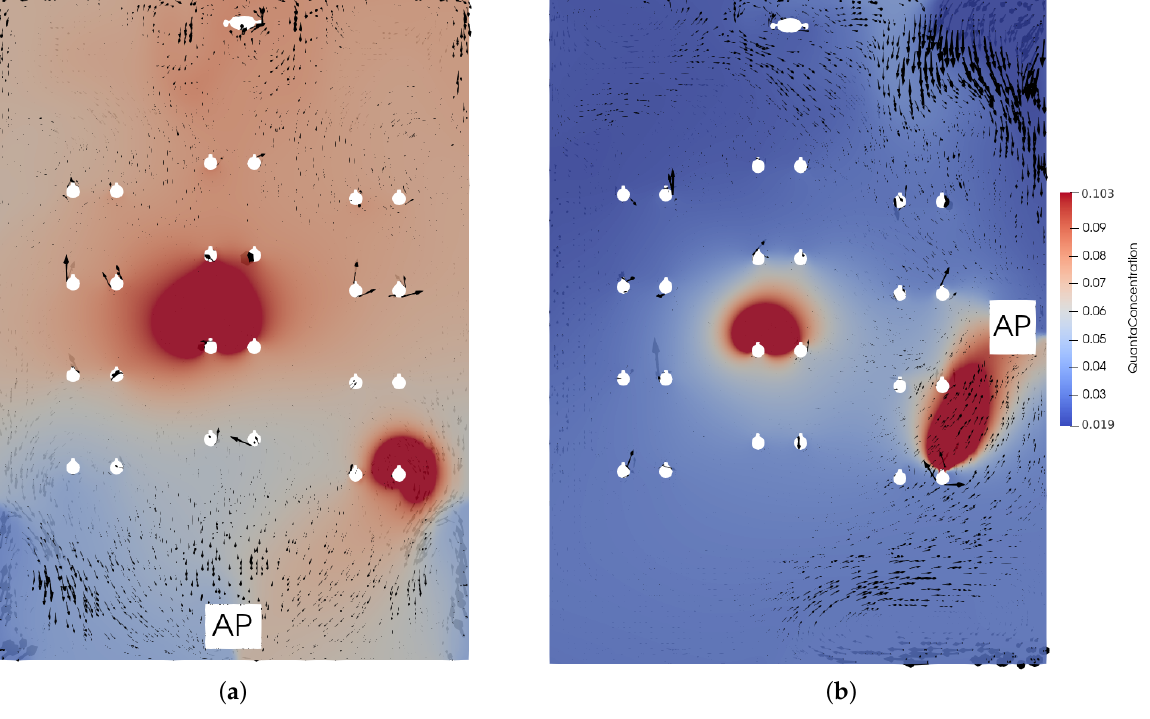
Figure 7. Quanta concentration and velocity vectors on the plane at the level of the mouths of students after 1 h in the classroom for Scenario 3 when the AP is on ( a ) the short side of the room, ( b ) the long side of the